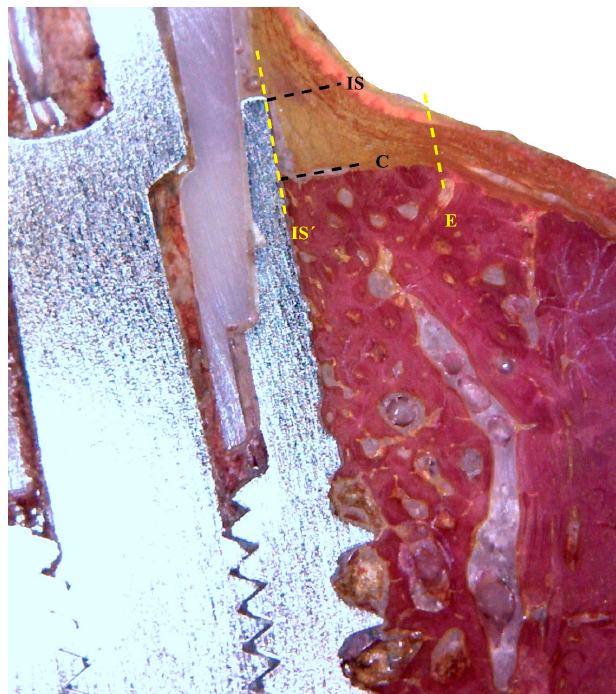
Figure 4. Linear measurements to assess peri-implant bone remodeling and peri-implant soft tissue remodeling. IS: implant shoulder; C: first bone-to-implant contact; IS´: implant surface; E: the most external portion of the epithelium.